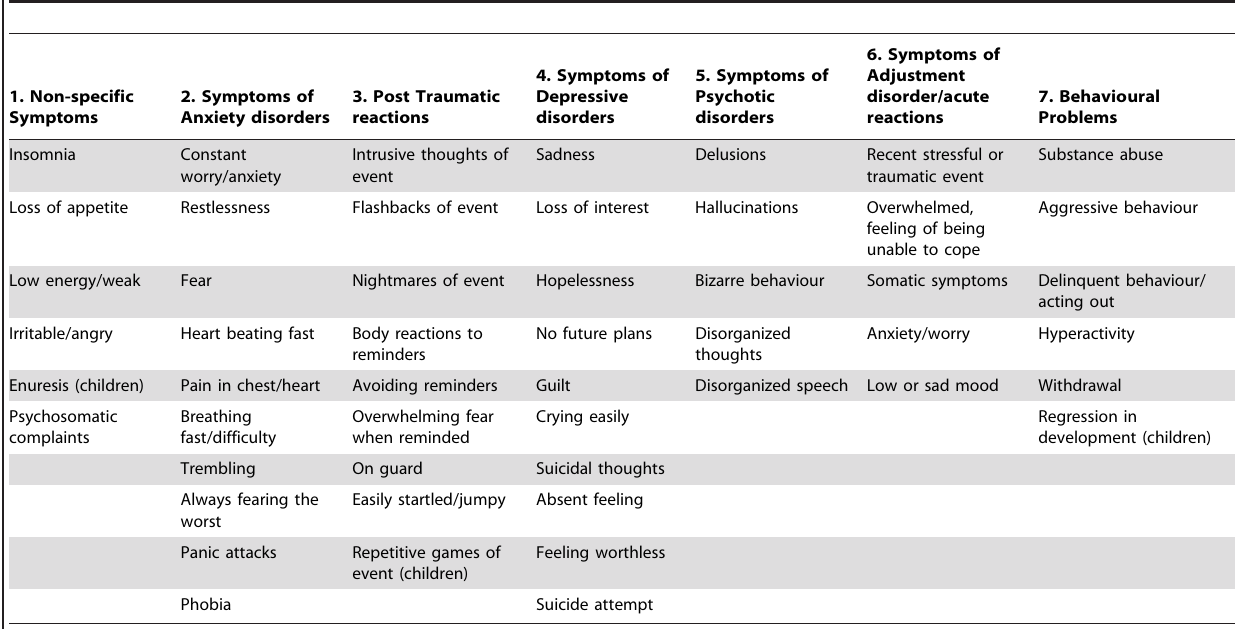
Table 2. Grading 2 of mental health morbidity (case definitions) amongst individuals seeking care in Timurgara district hospital, Pakistan (2012).